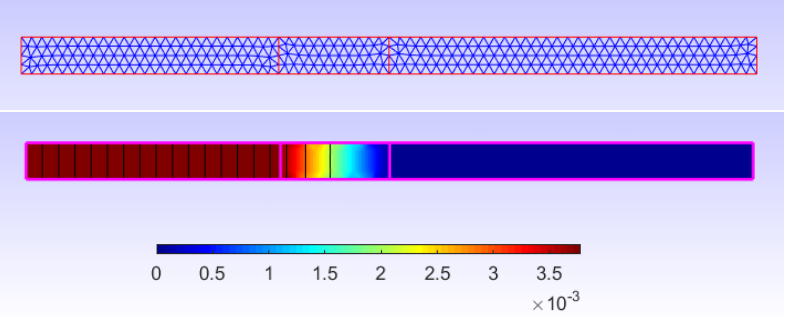
Figure 2. The mesh of the device ( top ) and the distribution of the magnetic flux density in T ( bottom ). A comparison of the quantities computed with the analytic and FEA was conducted, and the relative errors are then shown in Table 1. We noticed that we had fewer errors for energy than for B c . Generally speaking, FEA led to fewer errors for global quantities such as energy and higher errors for local quantities. Table 1. Comparison of analytic and FEA quantities. B c W Analytic 3.757 mT 4.5239 J/m FEA 3.592 mT 4.5225 J/m Rel. error 4.39